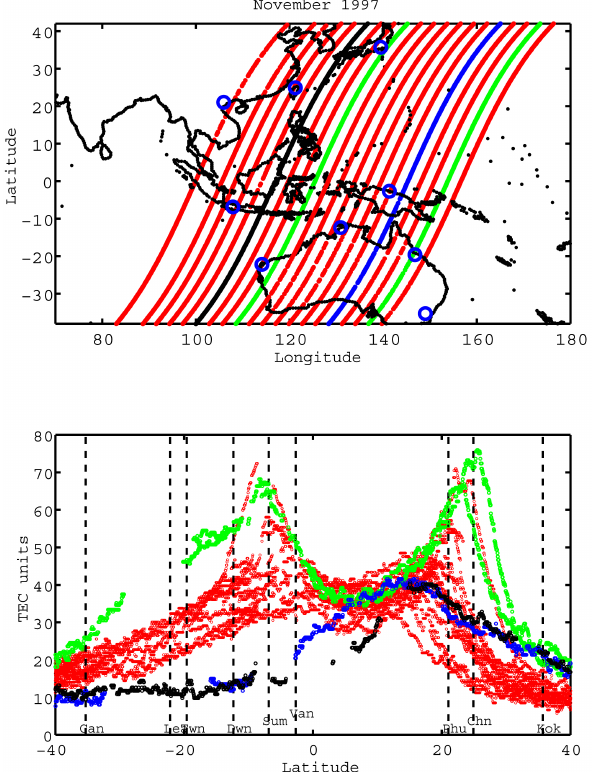
Fig. 8. TOPEX/Poseidon passes and corresponding TEC values ob- served between 14:08–12:08 LT over the period 31 October to 10 November 1997. Two negative ionospheric storm day passes on 8 November are shown in blue and black. Two passes on the previ- ous day are shown in green showing a possible positive ionospheric storm effect.